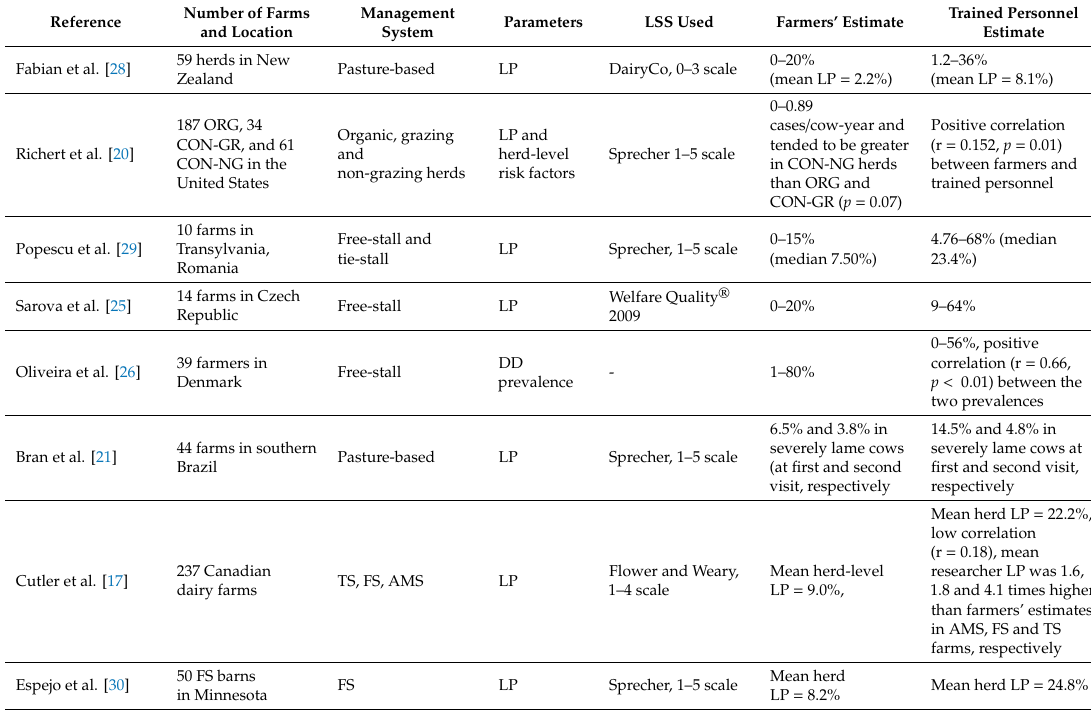
Table 1. Summary of the scientific literature evaluating lameness prevalence estimates between farmers and trained personnel in dairy